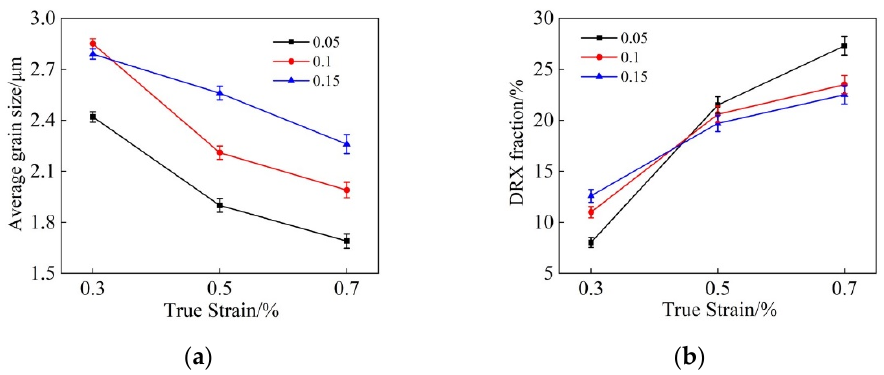
Figure 8. The ( a ) average grain size and ( b ) DRX fraction of the specimens with pre ‐